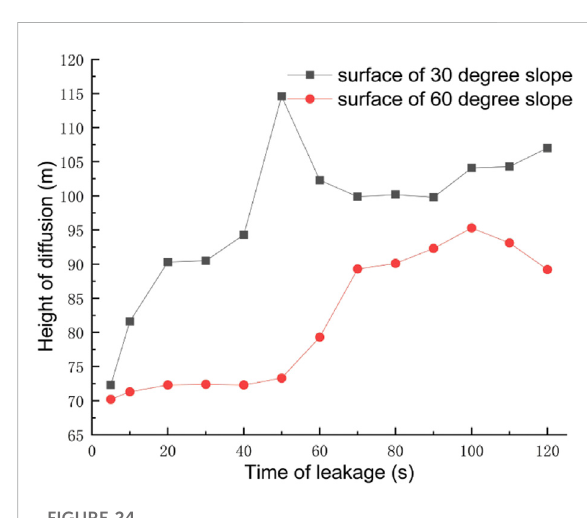
FIGURE 23 Diffusion height map of pipelines laid at the foot of the slope at different times.